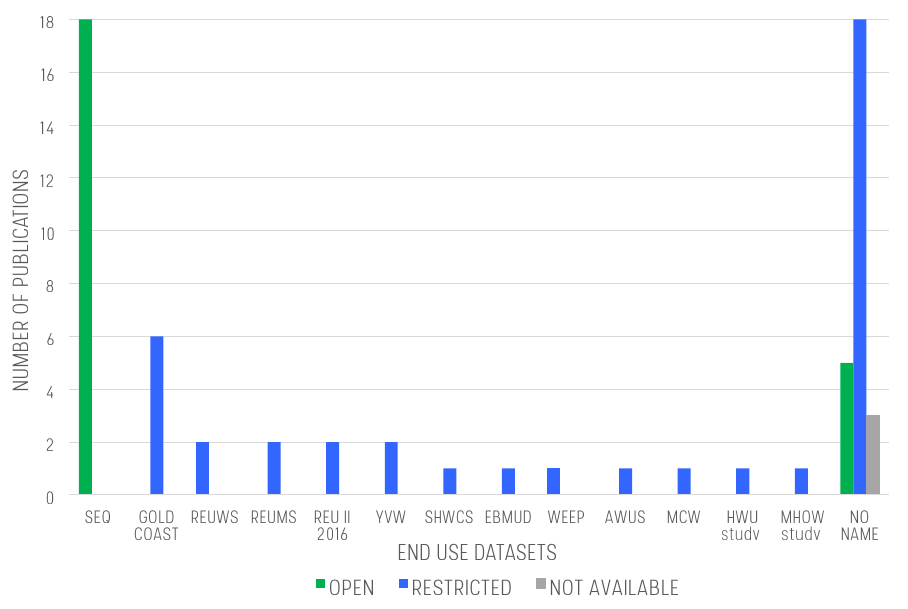
Figure 8. Usage frequency of different reviewed end use datasets. Each dataset is labelled with its name. The “no name” category includes datasets with no identification name and used only for ad hoc individual case studies and trial